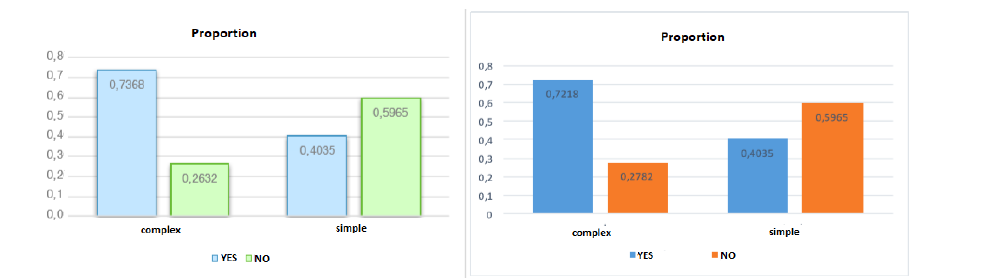
Figure I. Overall proportion of YES- Figure II. Overall proportion of YES- and NO-answers with all the sentences and NO-answers without